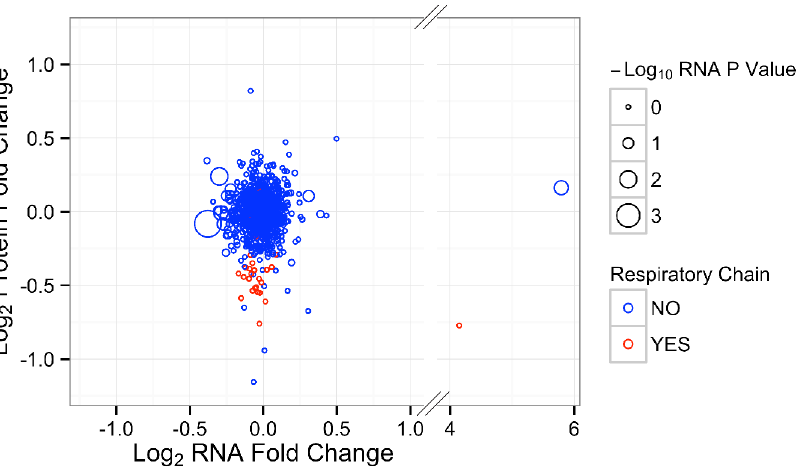
Figure 5. Comparison of iTRAQ and RNA-Seq datasets. The fold changes of 1001 proteins and gene transcripts that were measured using both iTRAQ and RNA-Seq were plotted against each other. Data points are colored by membership in the Uniprot gene ontology group ‘‘Respiratory Chain’’ and they are sized according to the adjusted p-value from the RNA-Seq dataset. The x-axis was broken to allow for easier visualization of all the data. The two data points to the right of the break represent Mtco2 and Tubb1 and have adjusted p values from the RNA-Seq experiment of 1 and 0.0289, respectively. doi:10.1371/journal.pone.0094646.g005 PLOS ONE |